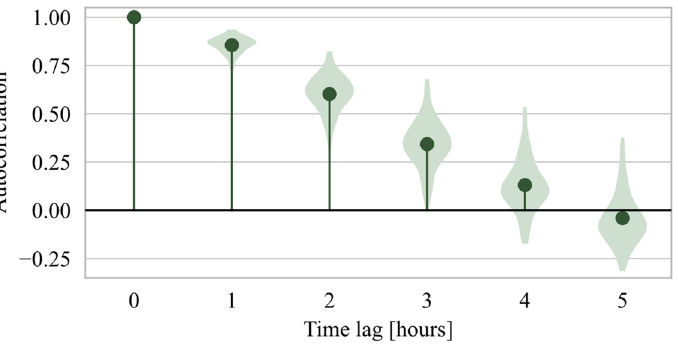
Figure 8. Correlogram of the observed discharge ( Q ) variable. Violin plots represent the distribution of values across the individual rainfall-runoff events.